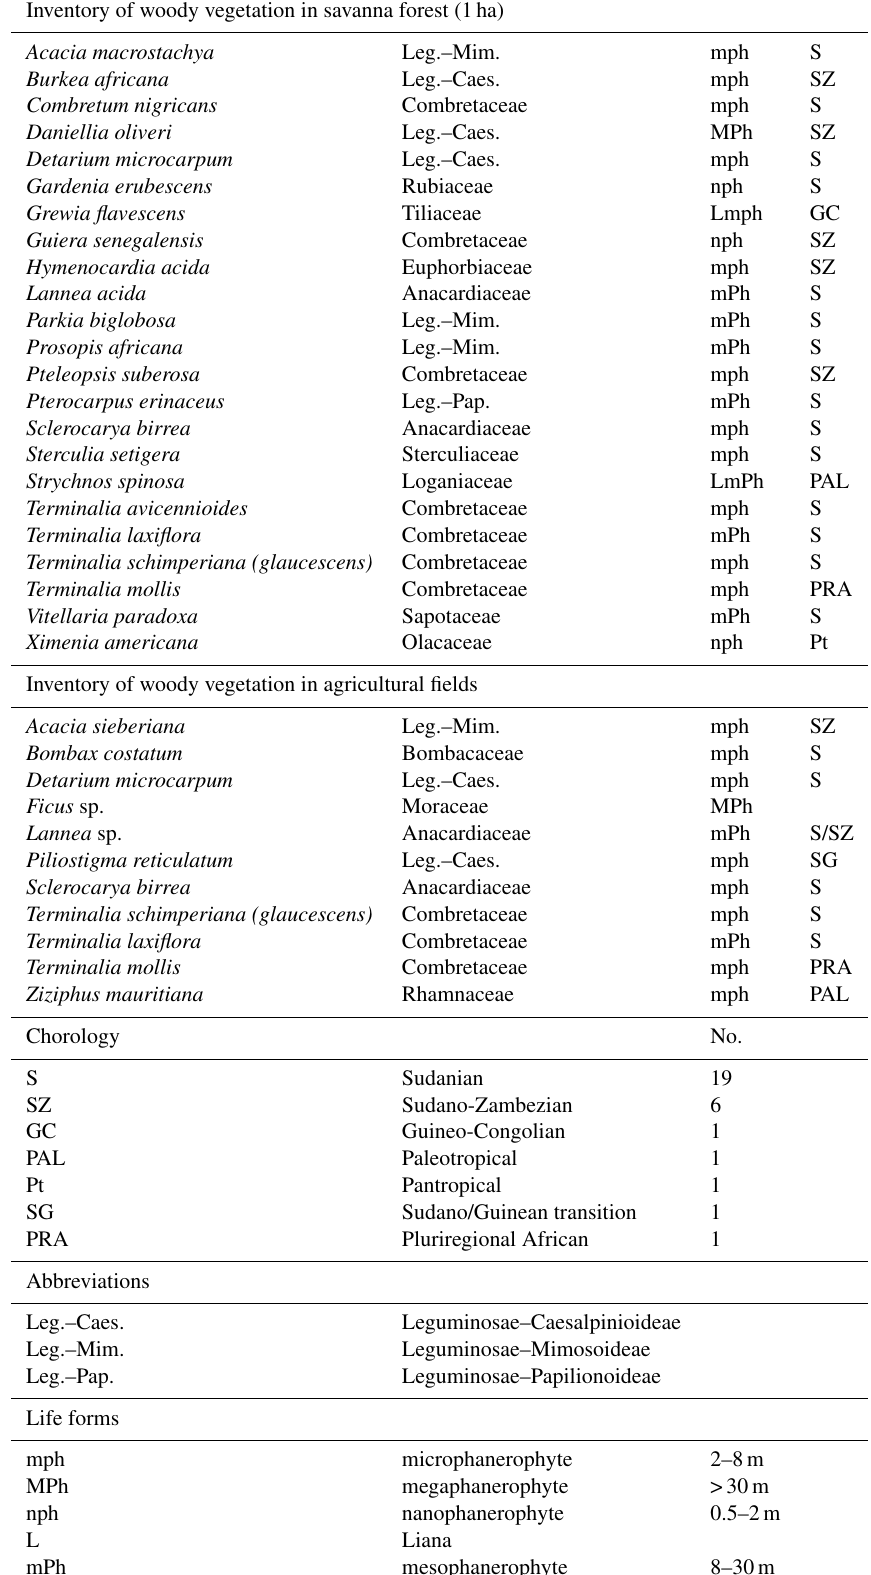
Table 2. Inventory of species found in both agricultural field site and savanna forest site. Inventory of woody vegetation in savanna forest (1ha) Acacia macrostachya